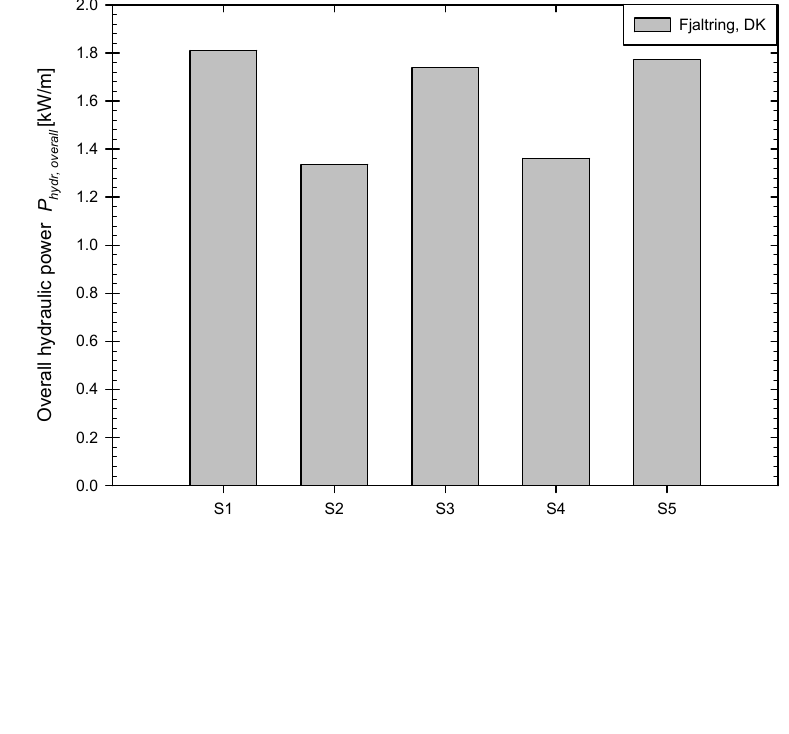
Figure B2. Comparison between effects of five scenarios on the overall hydraulic power for test site in Fjaltring, Danish Continental